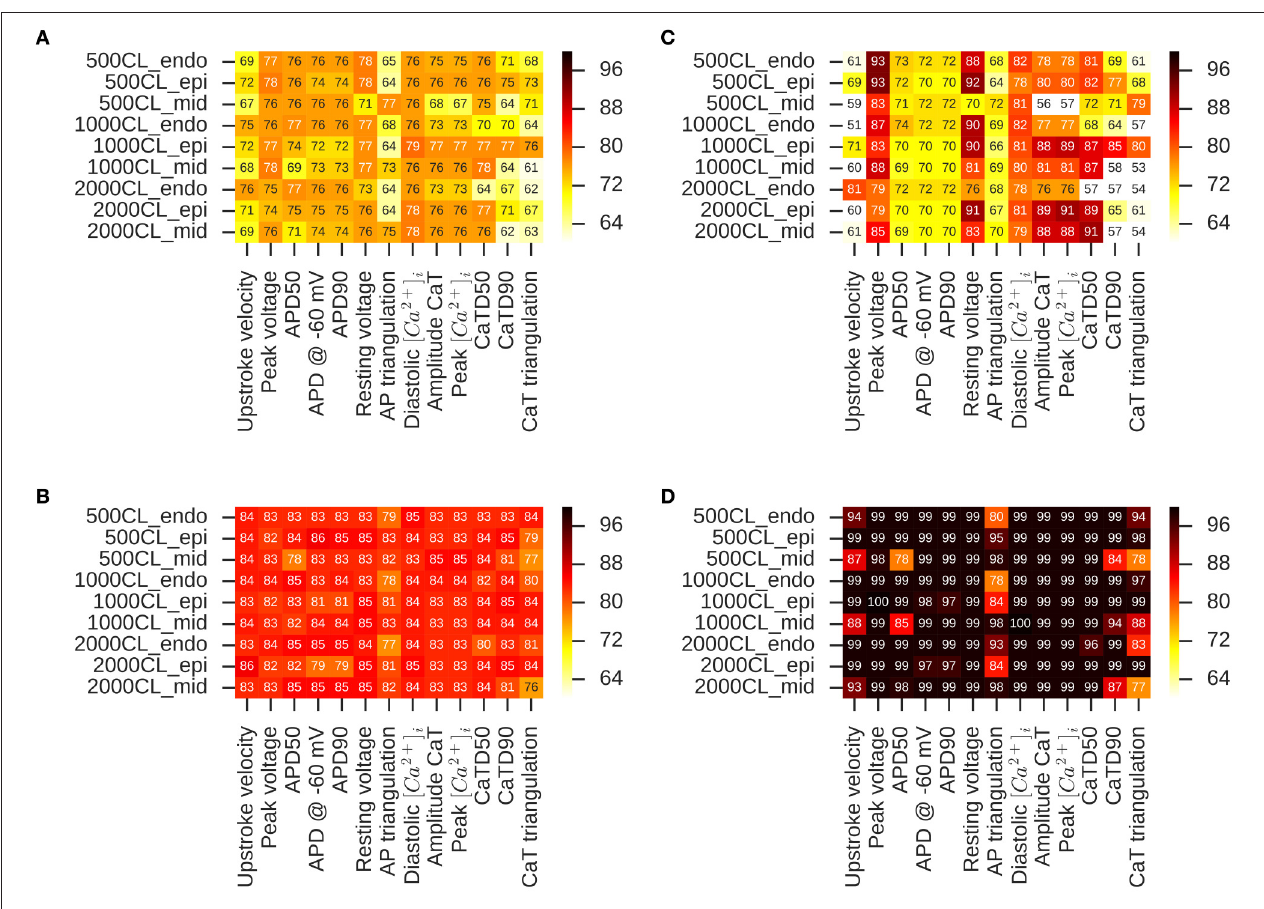
FIGURE 5 | Heat maps of leave-one-out cross validation scores for logistic regression classifiers built on 13 features extracted from the APs and Ca 2 + transients in OHR model simulations. Drug-induced multi-channel block evaluated in the mid, endo and epi cell types at 500, 1,000, and 2,000 ms pacing rates. TdP risk classification at (A) EFTPC drug concentrations and (B) drug concentrations equal to hERG IC 50 . EAD induction classification at (C) EFTPC drug concentrations (D) drug concentrations equal to hERG IC 50